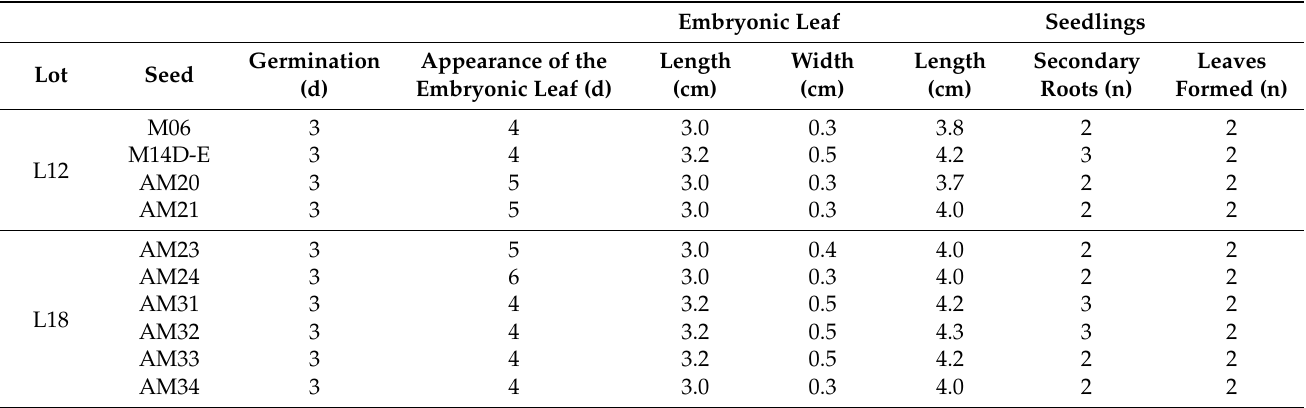
Table 2. Parameters of the embryonic leaves, roots and leaves formed in the seedlings from two germination lots selected for